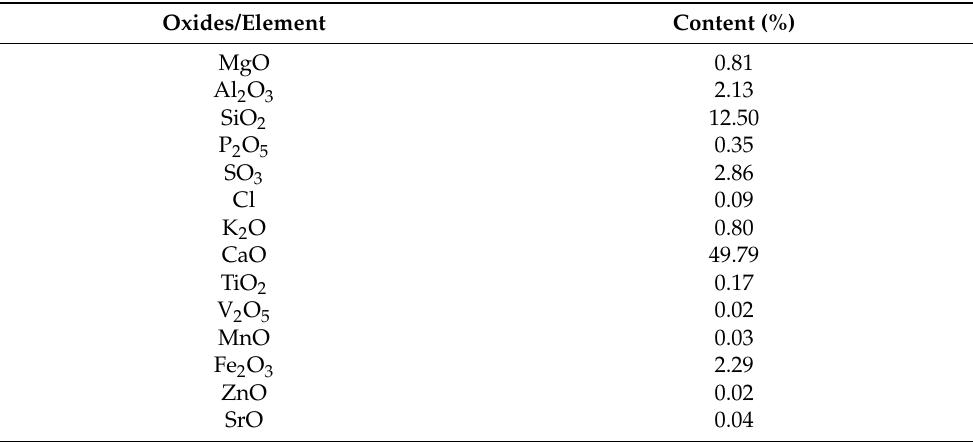
Table 1. Chemical composition of Portland cement CEM I 42.5 N.